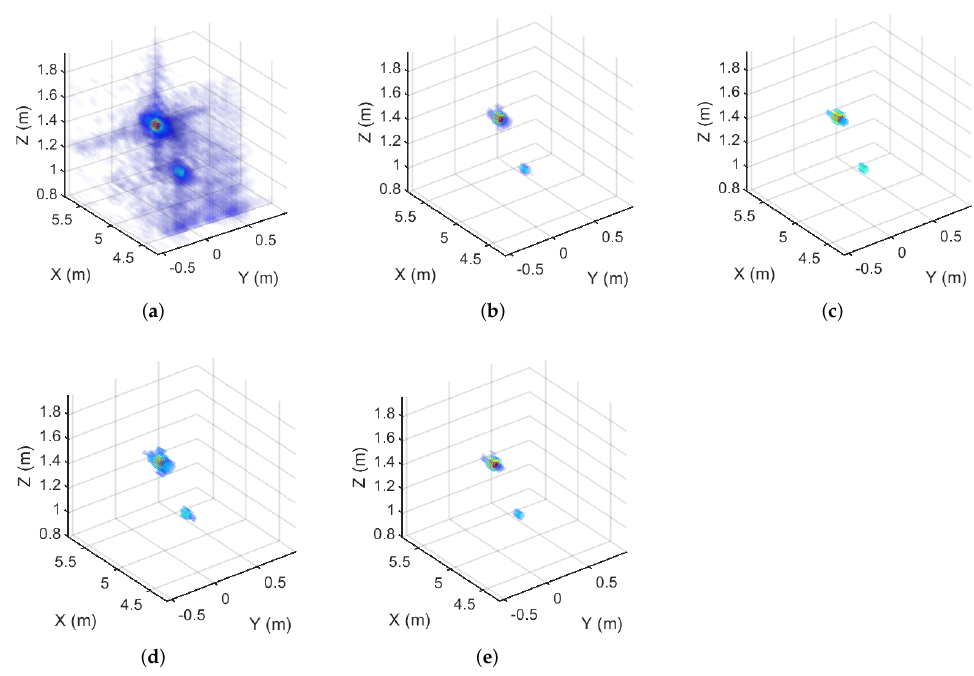
Figure 7. The imaging results of the real ground-based array SAR data corresponding to the 100% sampling rate. ( a ) The MF result. ( b ) The MM- L 1 result. ( c ) The MM- L 1/2 result. ( d ) The MM- L 0 result. ( e ) The GMM- L 0.8